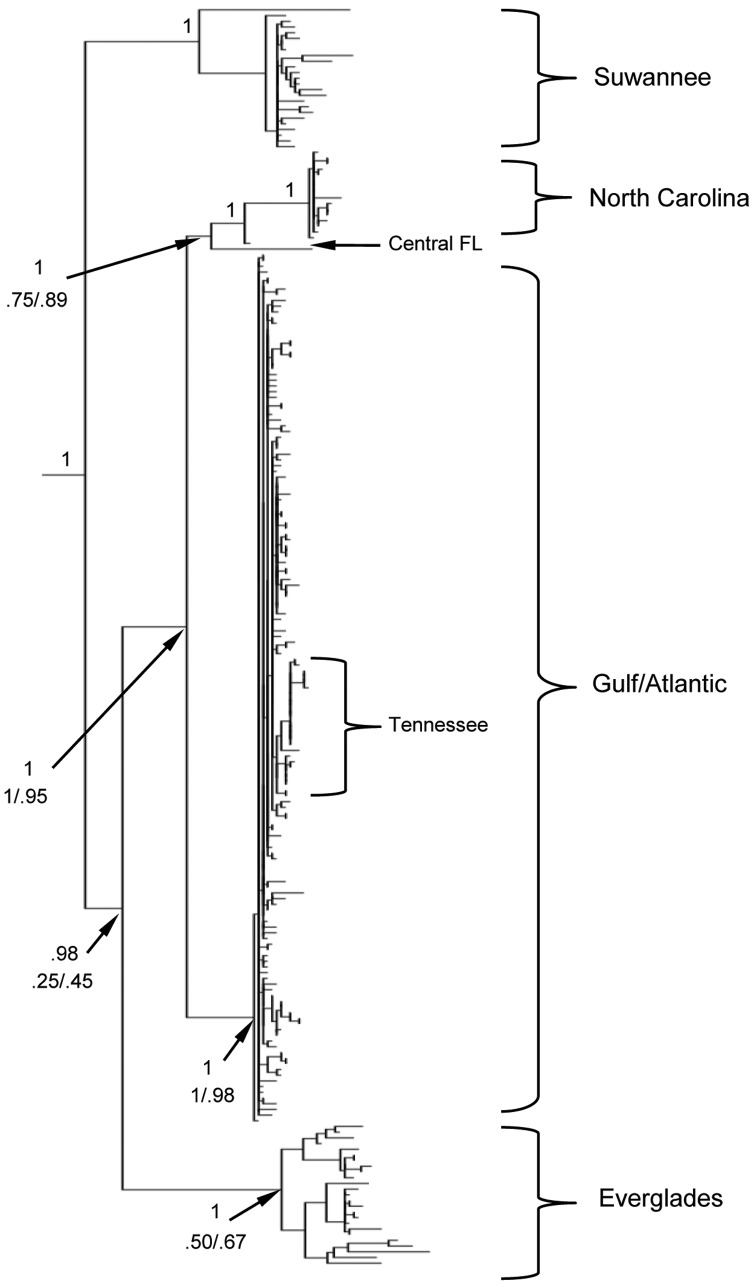
Phylogenetic reconstruction of the ND2 mitochondrial region.The most likely tree derived from the rapid bootstrap method (RBS) in RaxML is shown; the topologies of three methods (RBS, full likelihood, and Bayesian inference) were highly concordant. Posterior probabilities are given above important nodes; below nodes are the bootstrap values from RBS before the slash and from the full ML analysis after the slash. Nodes with 100% support in all three analyses are indicated with a 1. Outgroups (A. isolepis, A. altitudinalis and A. porcatus) are not shown. The four major clades (Suwannee, North Carolina, Gulf-Atlantic, and Everglades) are indicated with large brackets on the right. The Tennessee minor clade is shown, nested within the Gulf-Atlantic lineage. Two samples from central FL that clustered closer to the North Carolina clade are indicated with a black arrow.